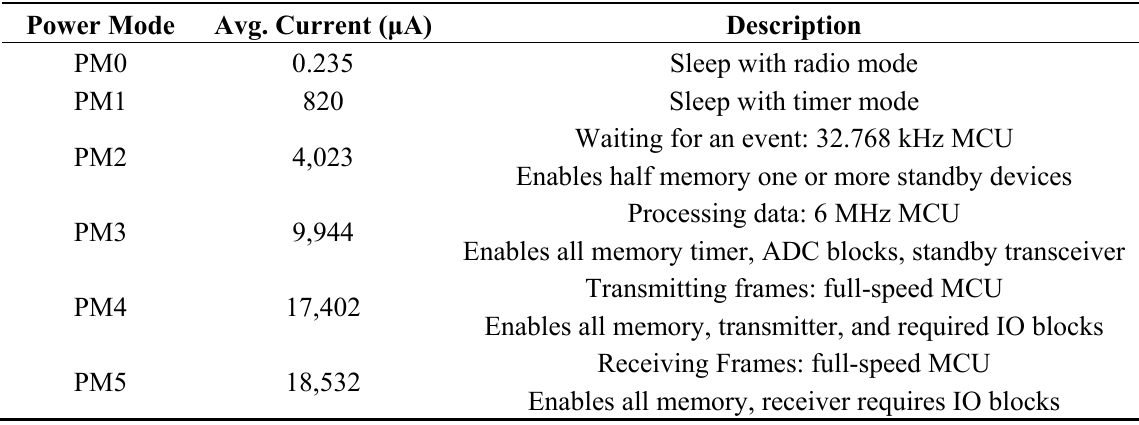
Table 2. Power modes and measured current in each mode.